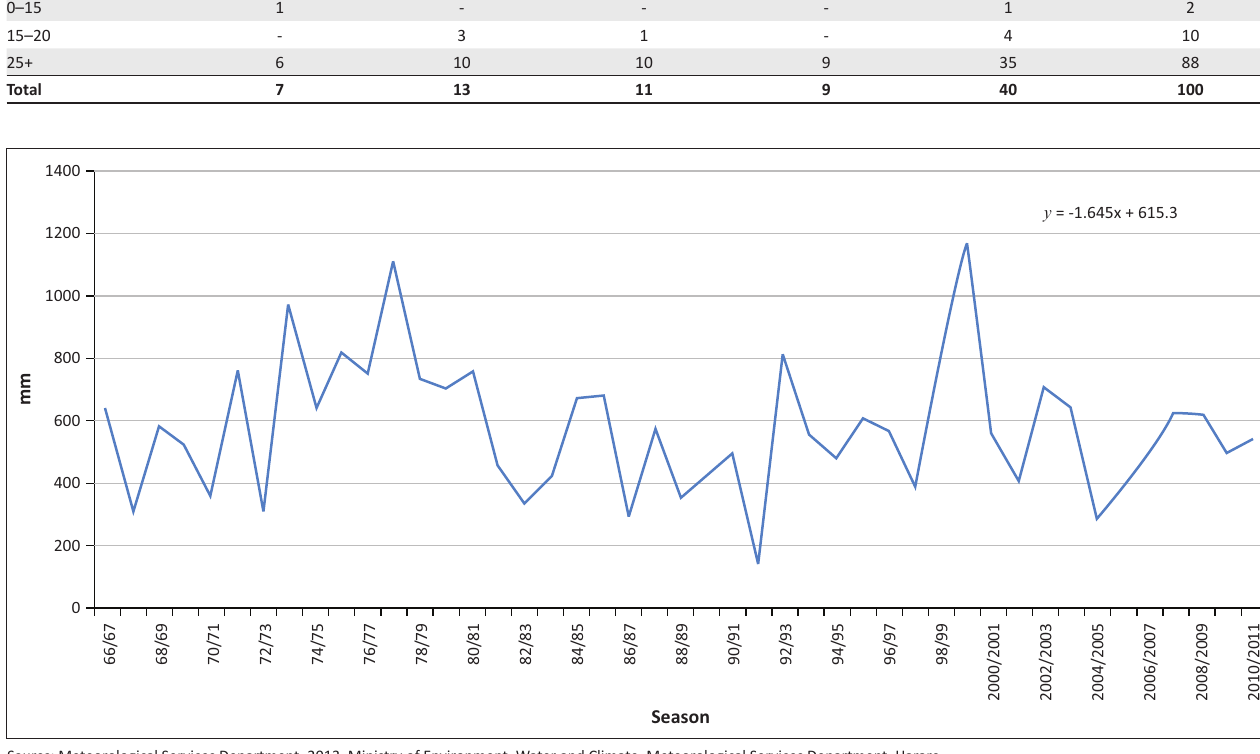
FIGURE 3: Educational qualifications. TABLE 2: Period of residence in Chilonga Ward. Period of residence in the